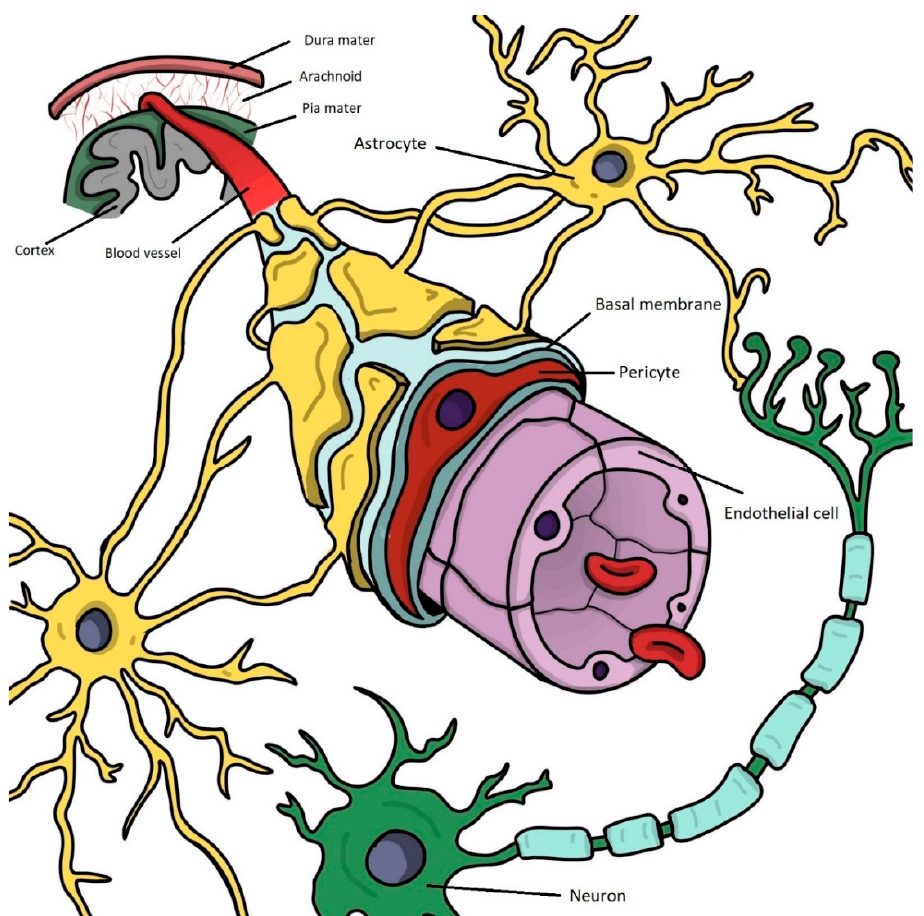
Figure 1. The complex structure of the neurovascular unit in physiological conditions: all components interact anatomically and chemically in a complex web to maintain its functions. Endothelial cells (purple), which make up the main part of the BBB, are characterized by high selectivity in transcellular transport, due to the tight junctions that fuse them together and restrict diffusion across the blood vessels. Pericytes (red) are essential cells in maintaining the structural and functional properties of the BBB and share a common basement membrane (blue) with endothelial cells. Astrocytes (yellow) are involved in supportive processes and have a strategic localization between neurons (green) and other components of the BBB, with their specialized end feet extending to the walls of the blood vessels. (Magda Pîr ț ac designed this figure by using Adobe Fresco.)